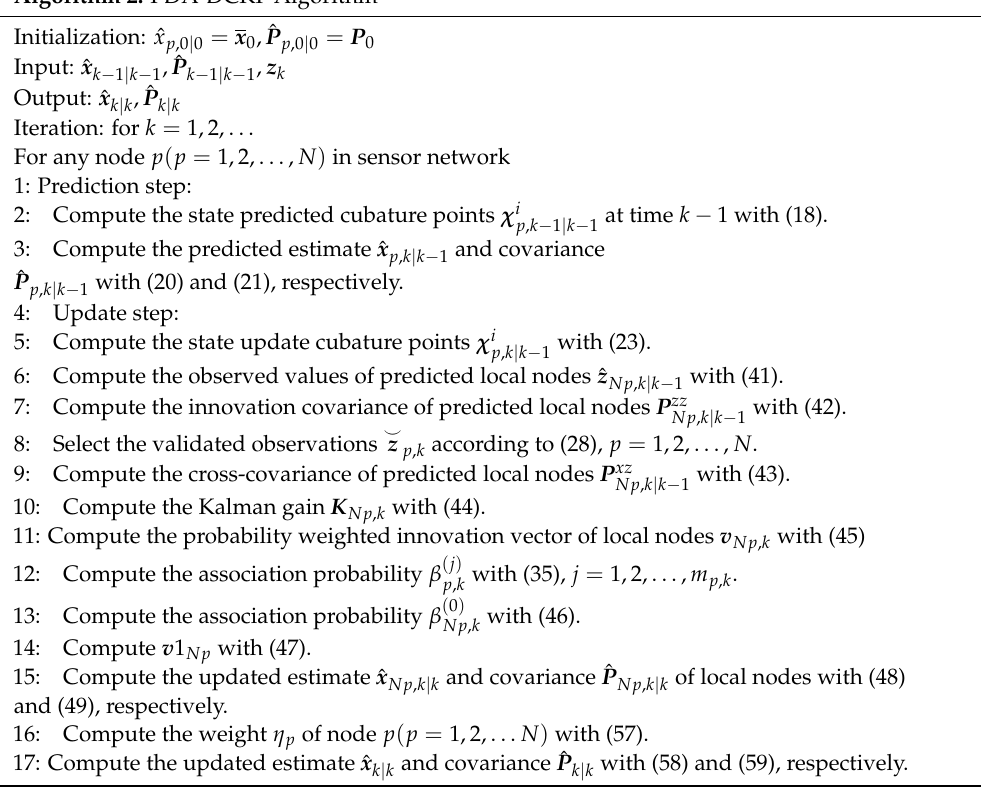
Algorithm 2: PDA-DCKF